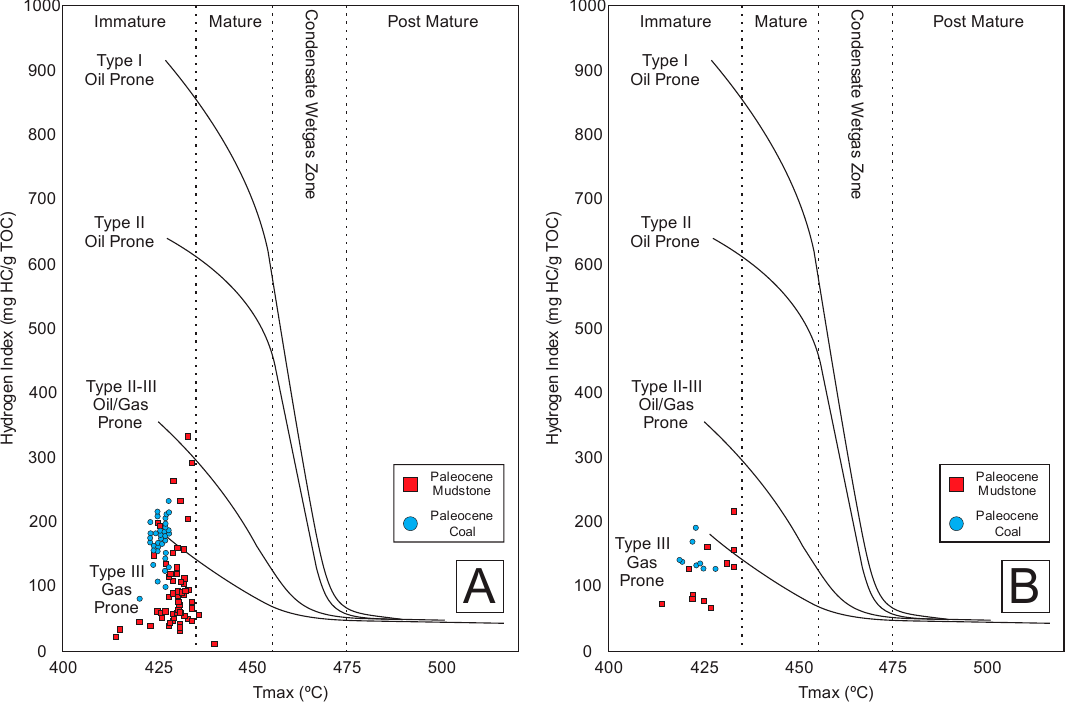
Figure 12. Cross plot between hydrogen index (HI) (mgHC/g TOC) versus maximum pyrolysis temperature (Tmax) to indicate source rock maturity in the Cerrejón Formation of the ( A ) ANH-CARRETALITO-1 and ( B ) ANH-CAÑABOBA-1 wells.